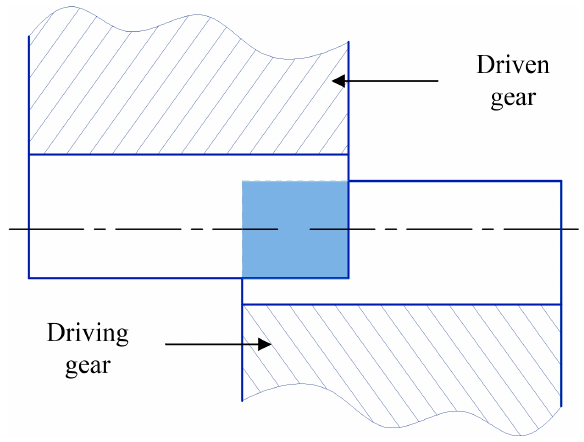
Figure 3. Schematic diagram of one ‐ third of the tooth width meshing.